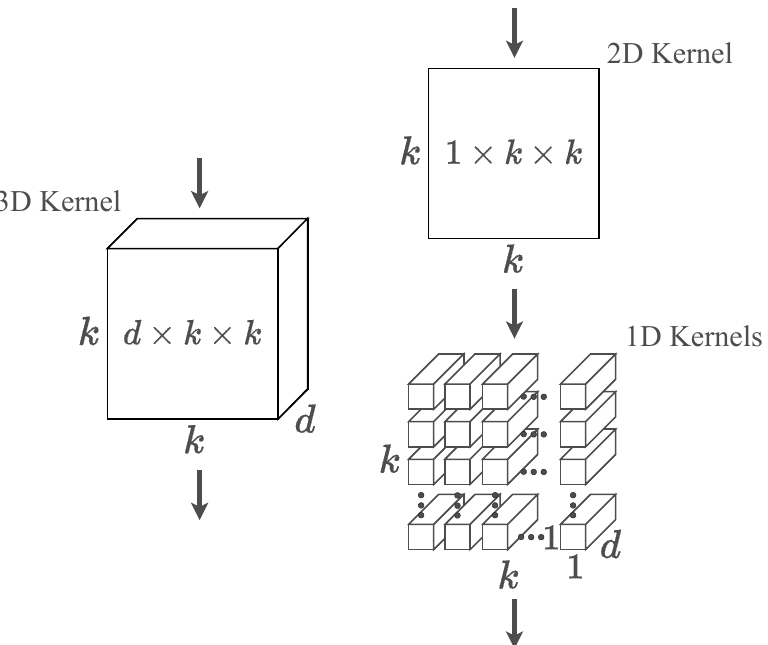
Figure 3. 3D vs (2 + 1)D. Factorisation of the spatiotemporal 3D convolution into a spatial 2D Figure 3. 3D vs (2+1)D. Factorization of the spatiotemporal 3D convolution into a spatial 2D convolution followed by temporal 1D convolution followed by temporal 1D convolutions.